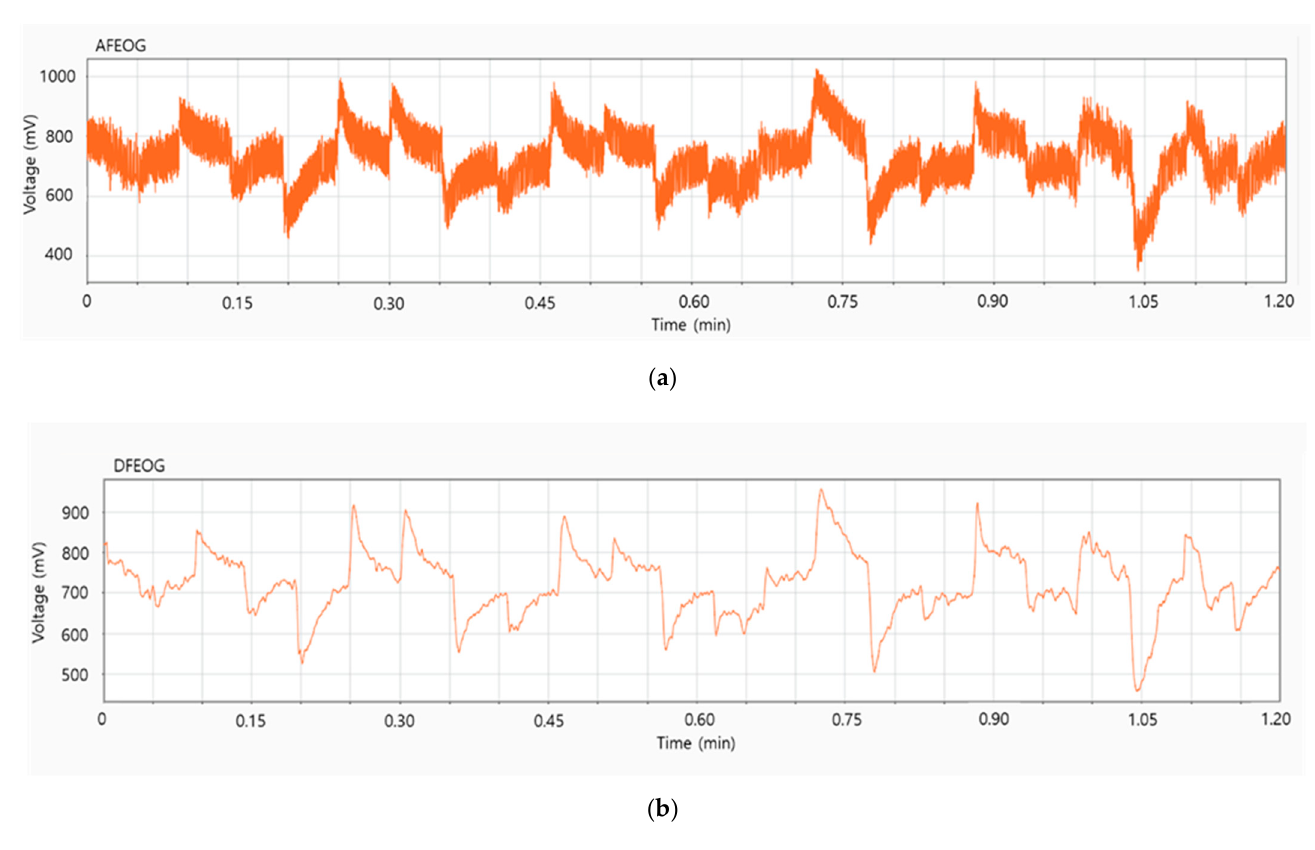
Figure 5. Comparison of EOG signals: ( a ) analog filtered EOG signal (AFEOG); ( b ) digital filtered EOG signal (DFEOG) using the AFFOG signal.